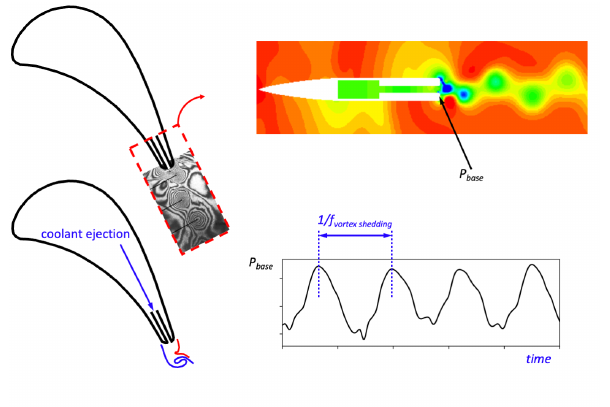
Figure 1. Representational scheme of trailing edge base region flow, together with static pressure contours and static pressure time series. Image partially reproduced from Martinez-Cava et al. [19]. Copyright © 2021, published by Elsevier Masson SAS. All rights